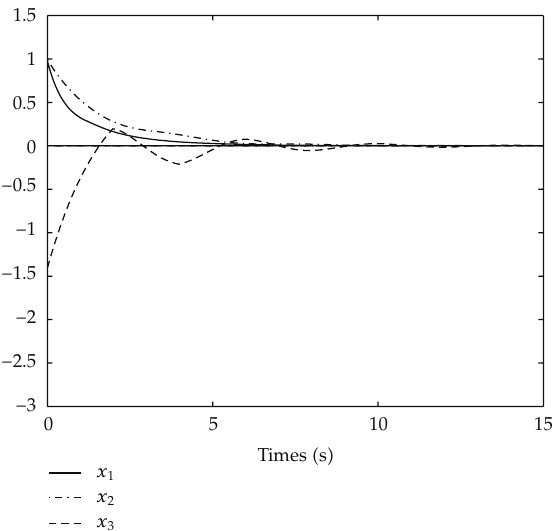
Figure 1: State responses x (cid:2) t (cid:3) of the original system.